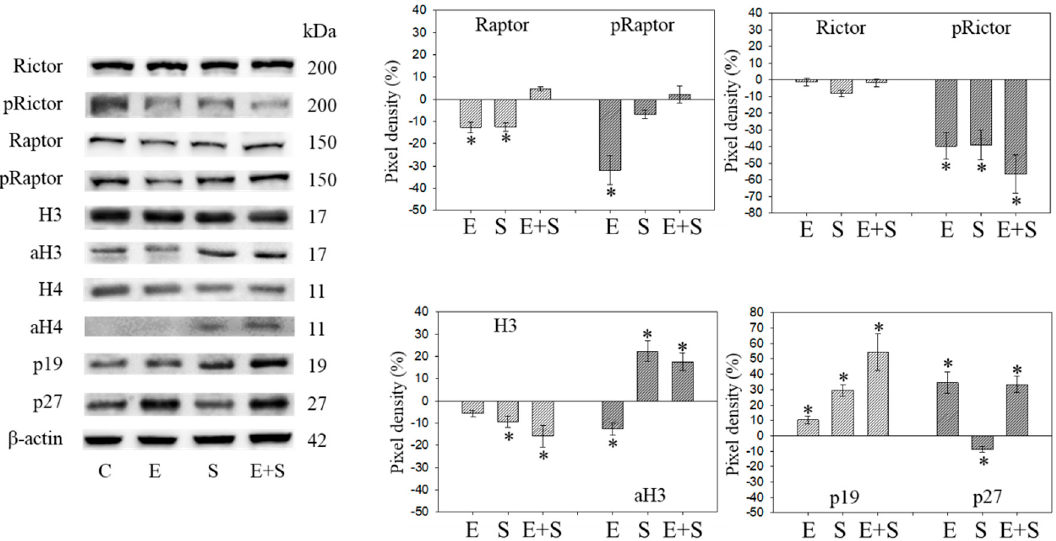
Figure 5. Protein profile of cell cycle regulating proteins (Rictor, Raptor, histone acetylation, p19, p27) after short-term exposure to 0.5 nM everolimus (E) or 2.5 µM sulforaphane (S) or 0.5 nM everolimus + 2.5 µM sulforaphane (E + S) in synchronized RT112 tumor cells. Controls (C) received cell culture